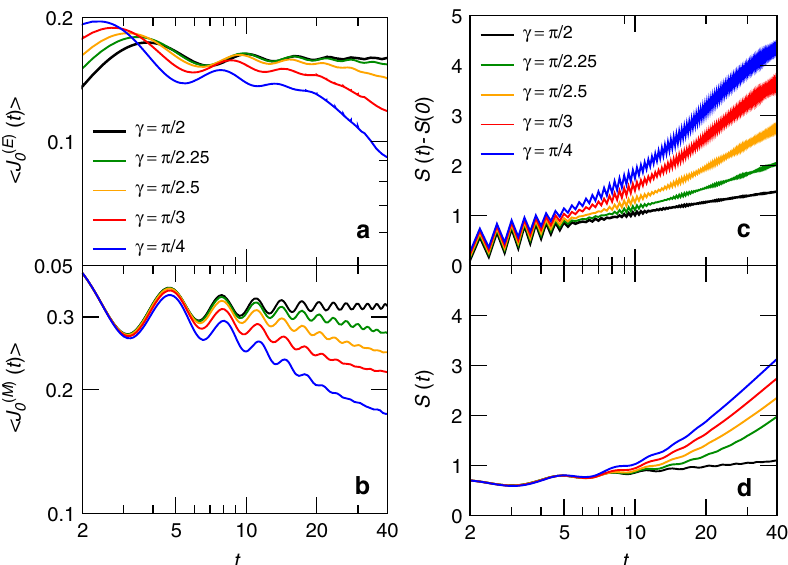
Fig. 5 Behaviour at the junction. Decay of the current at the junction: a energy-transport scenario; b spin-transport scenario. Time-dependence of the entanglement entropy of a system bipartition: c energy-transport scenario; d spin-transport